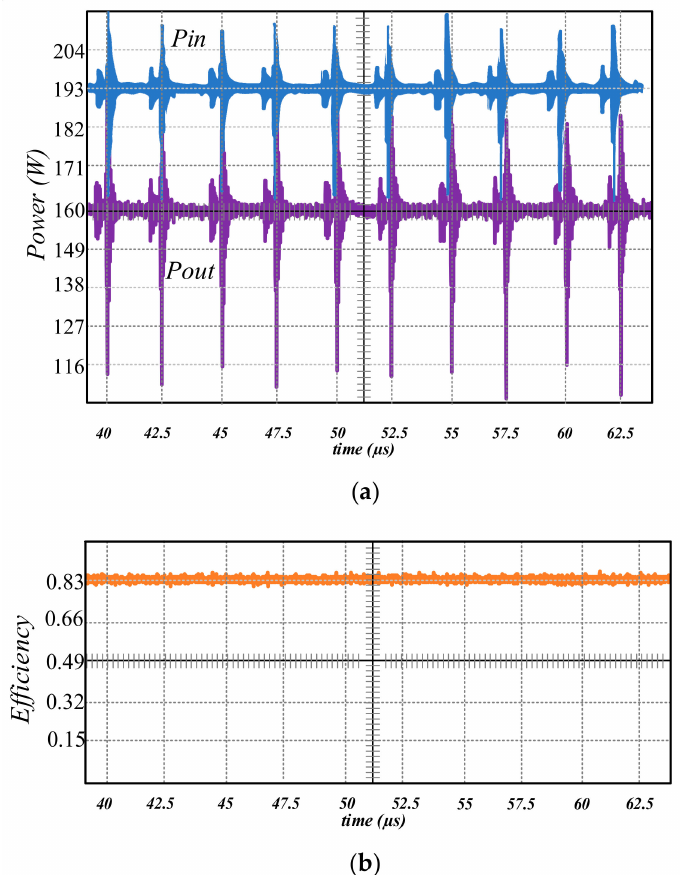
Figure 11. Electrical signals implemented by the first array: ( a ) input and output power, and ( b ) e ffi ciency.